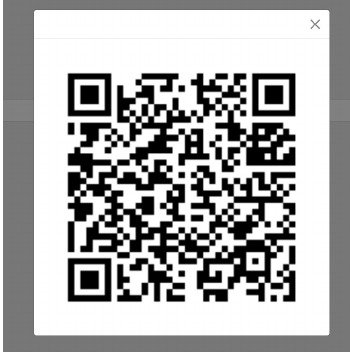
Fig 5. Login screen of the eKYC platform Fig. 9. QR code with relevant information generated after user request approved